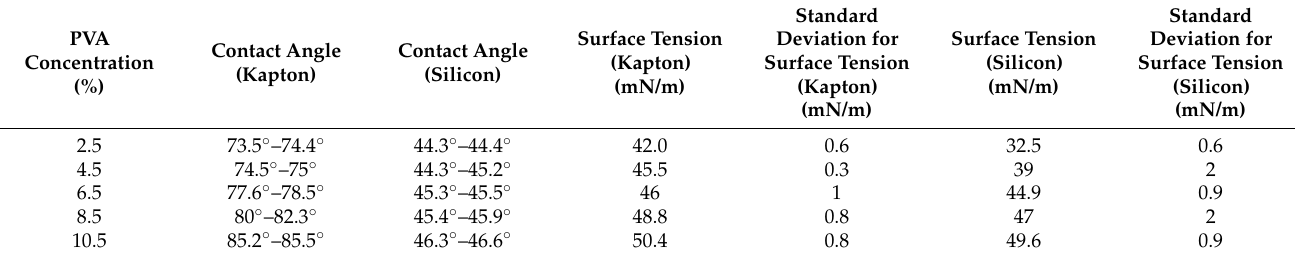
Table 2. The summary of the contact angle on Kapton and Silicon without surface